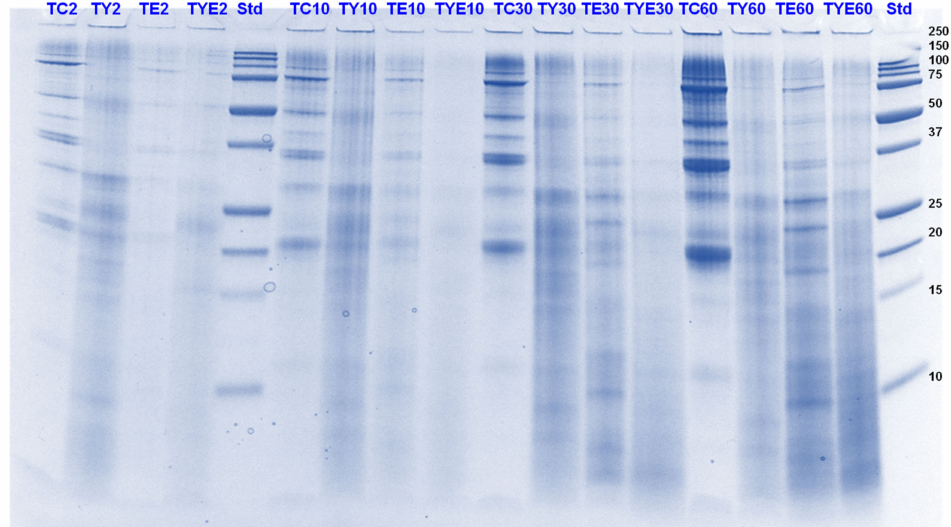
Figure 7. Tricine SDS-PAGE electrophoretogram of tofu (T) digest after 2, 10, 30 and 60 min of simulated oral-gastric digestion in the presence or absence of SunGold (Y) kiwifruit extract. TC, Tofu (T) control without any digestive enzymes; TK, with added kiwifruit extract but no digestive enzymes; TE, with digestive enzymes but no added kiwifruit extract; TYE, with both digestive